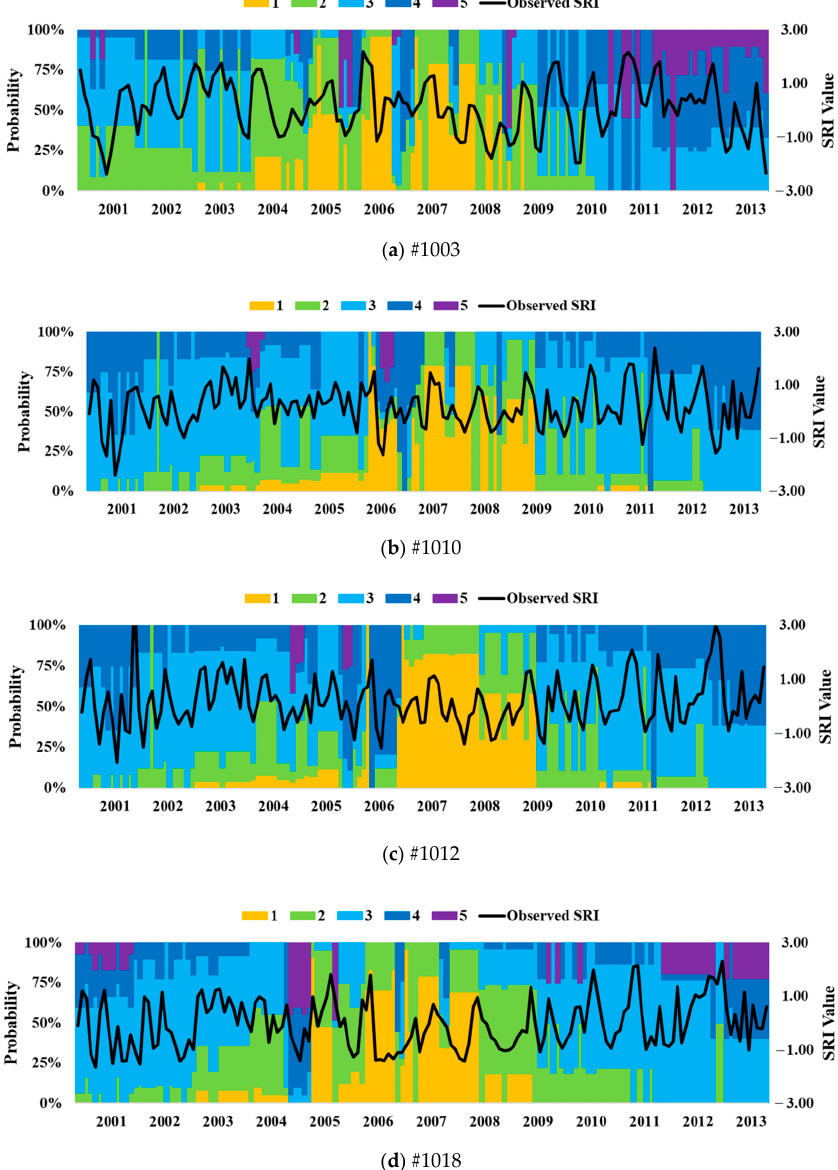
Figure 6. Probabilistic distribution of different classes of hydrological drought assessed through MBC during 2001–2013 and compared with the observed SRI. ( a ) Sub-basin #1003, ( b ) Sub-basin #1010, ( c ) Sub-basin #1012, ( d ) Sub-basin #1018.